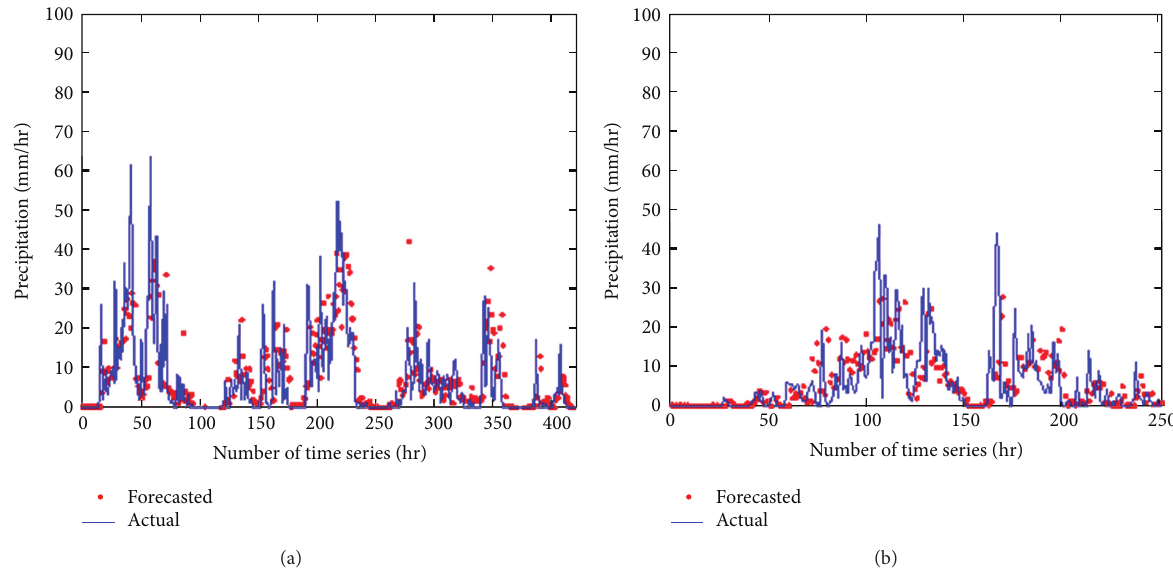
Figure 19: The validation and testing precipitation forecast results at 𝑡+2 of the ANFIS-based coupled hybrid dual-model at Hsia-Yun station: (a) validation; (b)